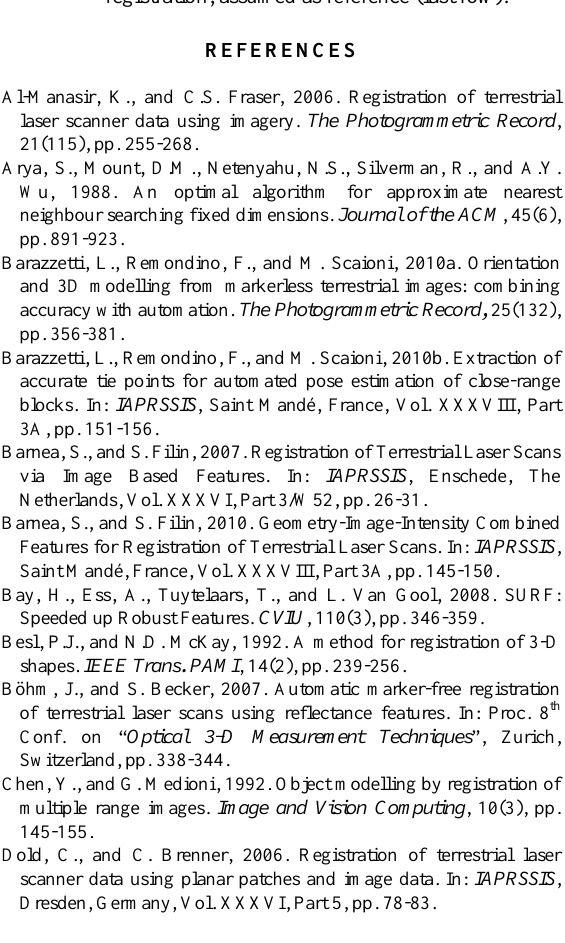
Table 6. Residuals on check points according to different configurations and to the retro-reflective target registration, assumed as reference (last